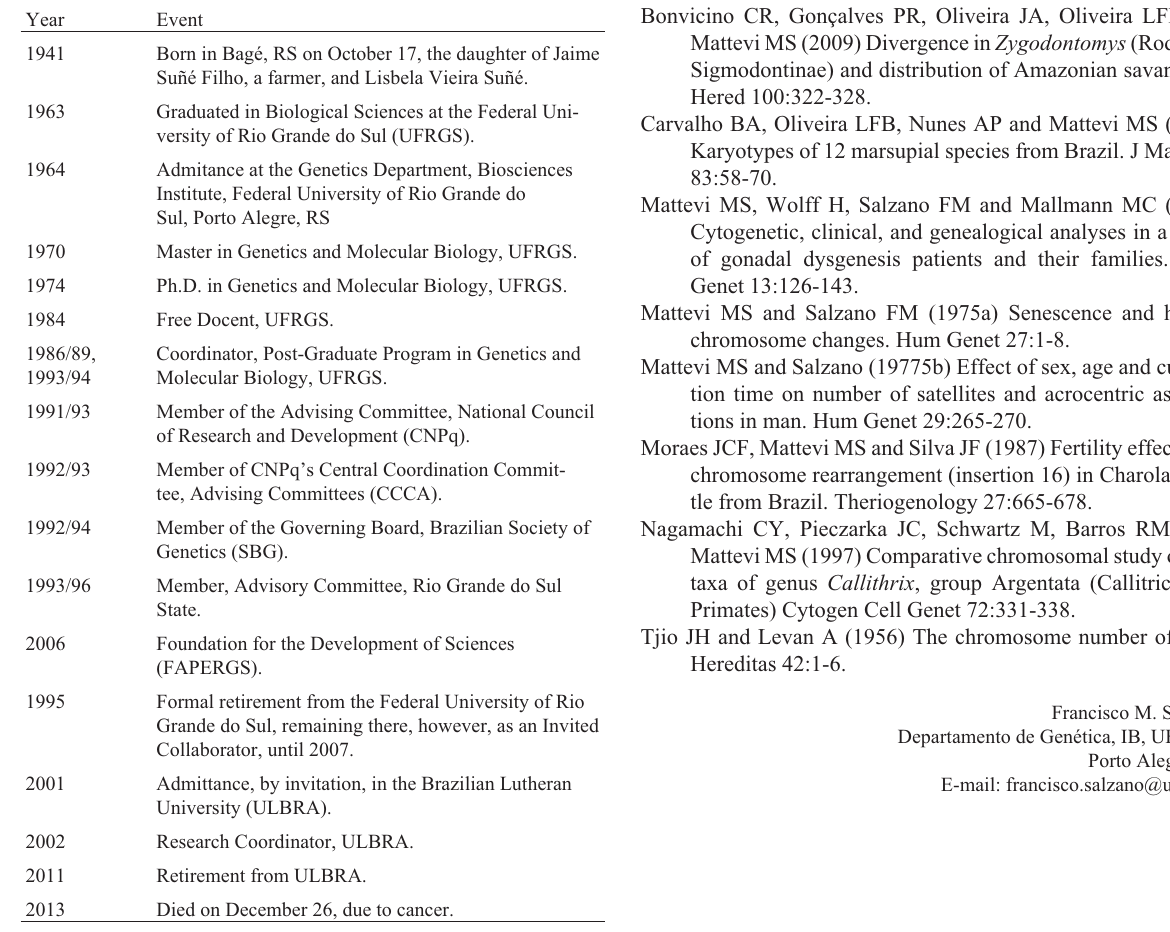
Table 1 - Main events related to the life of Margarete Suñé